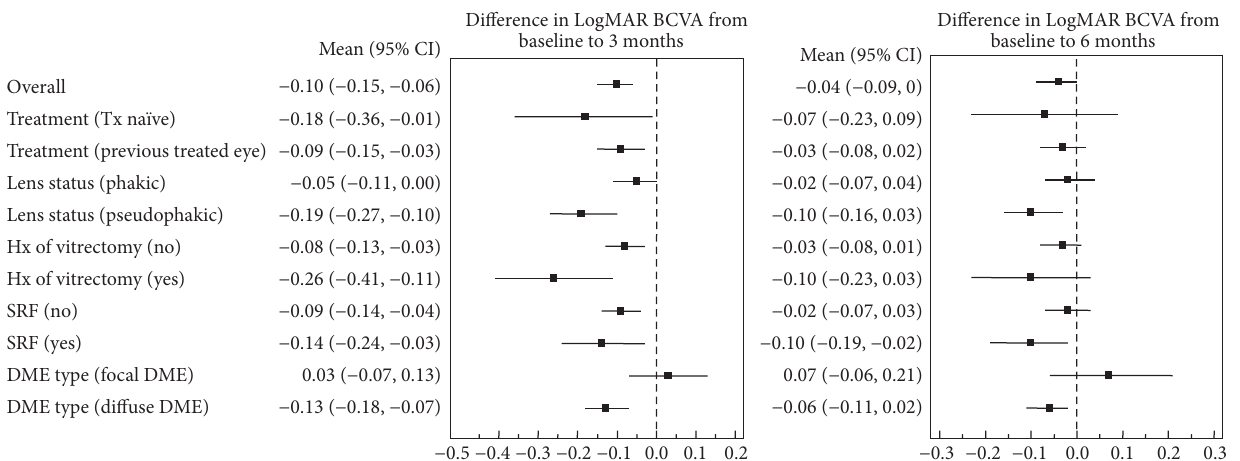
Figure 4: Forest plots of the mean change in BCVA (95% confidential interval) from baseline to months 3 and 6.